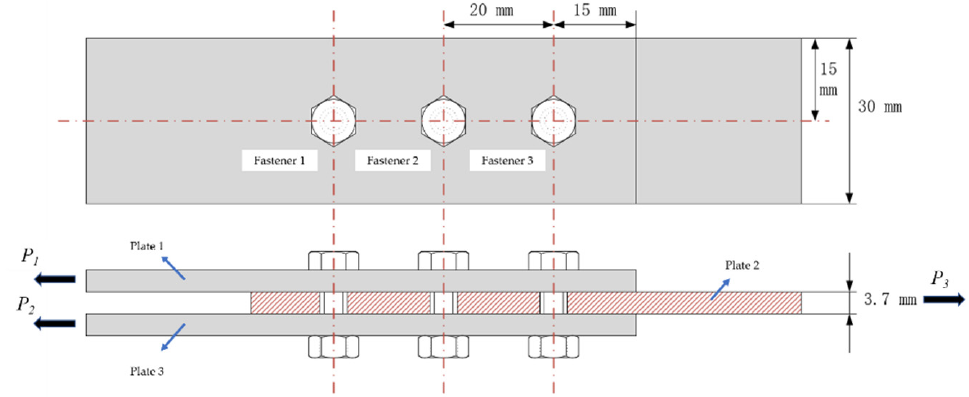
Figure 3. Schematic diagram and geometrical dimensions of the bolted joint. Table 1. The material parameters of the composite laminates.